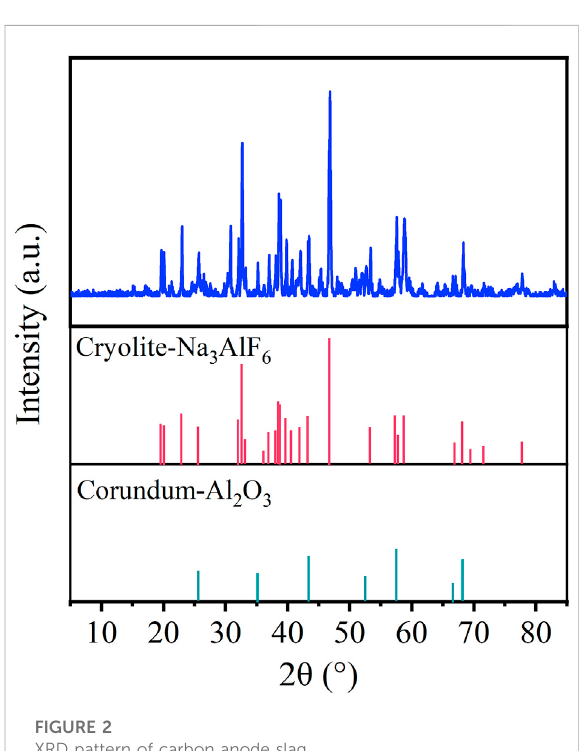
FIGURE 2 XRD pattern of carbon anode